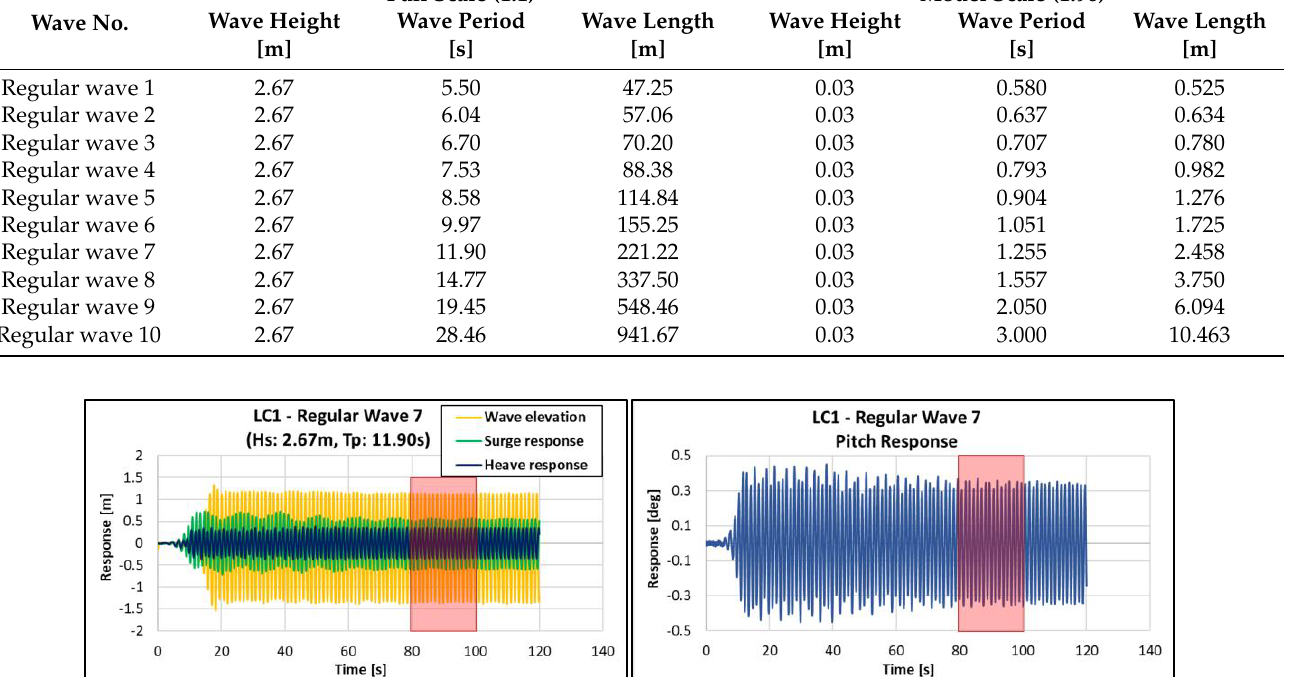
Figure 7. LC1 Regular wave7 Time-series response.